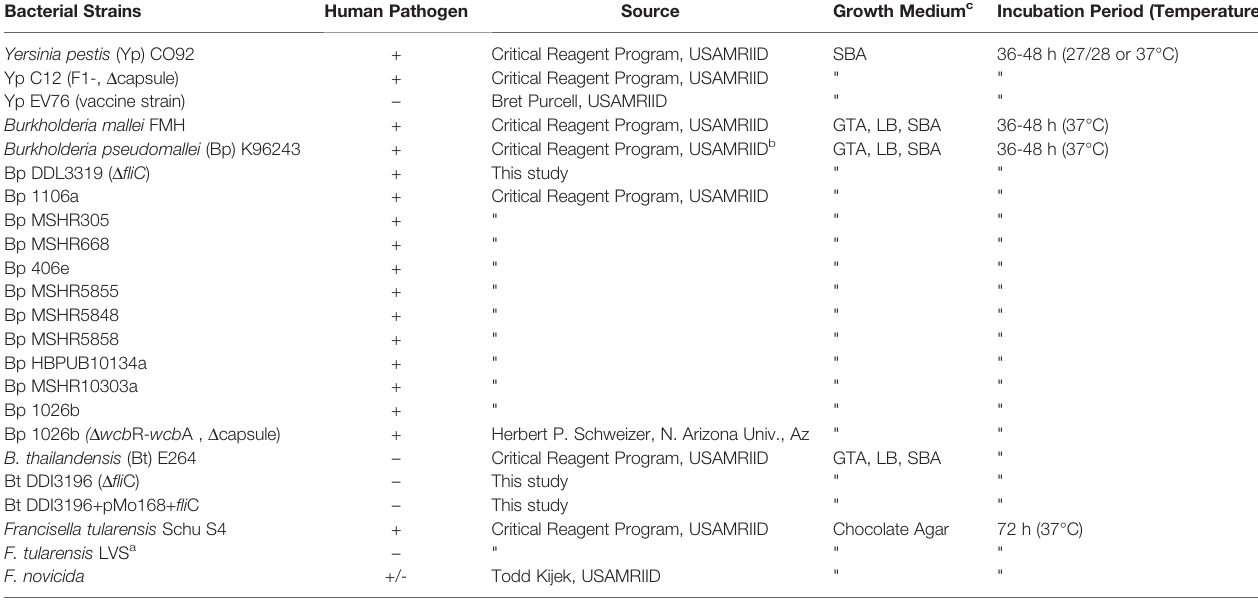
TABLE 1 | Bacterial strains used in the present study. Bacterial